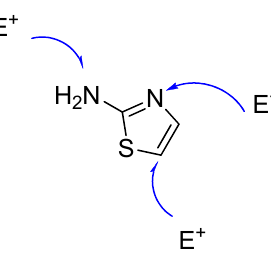
Figure 2. Three possible ways of the reaction between 2-aminothiazole and electrophiles.